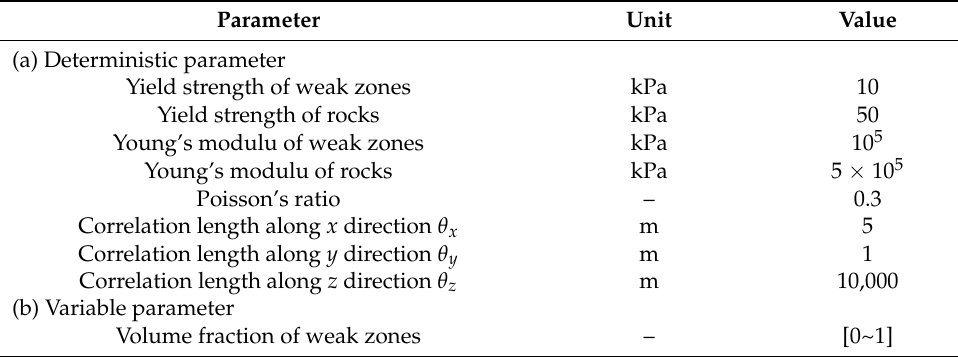
Figure 8. A typical realization of two-phase random media for a slope with a weak zone fraction equal to 0.5 (the black area represents weak zones, and the gray area represents rock). ( a ) Schematic diagram of a typical 3D slope with weak zones (3D model used in this research); ( b ) schematic diagram of a typical two-dimensional slope with weak zones. Table 2. Material mechanical parameters of the validation slope model.